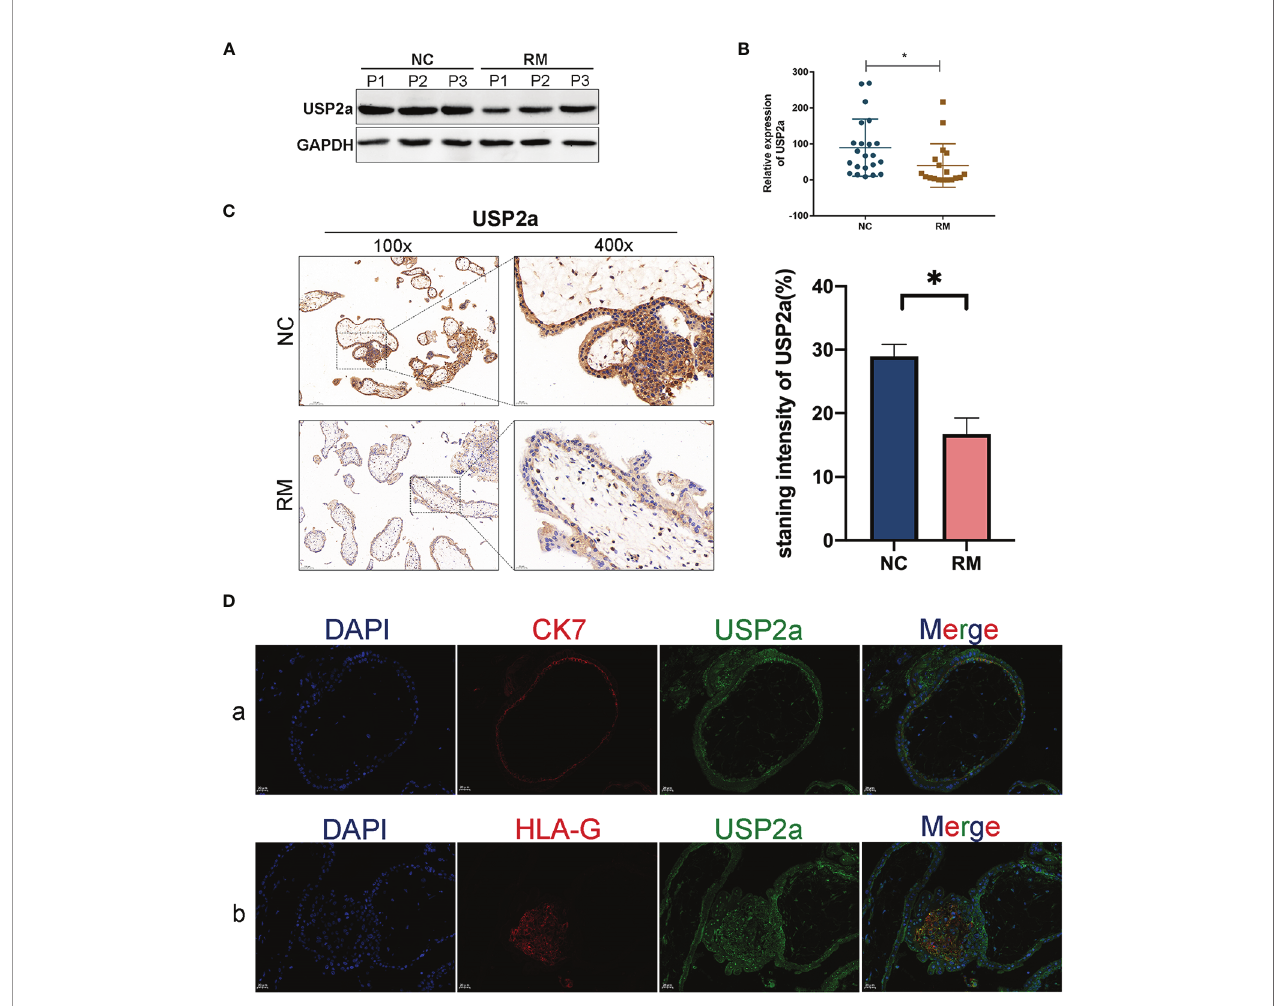
FIGURE 1 | USP2a is down-regulated in placental in patients with recurrent miscarriage (RM). (A, B) Comparison of relative mRNA and protein expression levels of USP2a in placental villous tissues between RM patients (n = 18) and normal women (n = 22) by RT ‐ PCR and western blot. (C) Representative immunohistochemical images of villous expression and localization of USP2a in RM patients (n = 22) and normal women (n = 25). The staining intensity was quanti fi ed using the ImageJ software. Graphs show the means ± SD. Magni fi cation, 100× and 400×. (D) Representative immuno fl uorescence images: (a) double immune-staining of CK7 (red) and USP2a (green). Magni fi cation, 400×; (b) double immune-staining of HLA-G (red) and USP2a (green) Magni fi cation, 400×. * P < 0.05. Scale bar = 100 m m (100×); Scale bar = 20 m m (400×). mRNA, messenger RNA; RT ‐ PCR, quantitative real ‐ time polymerase chain reaction; RM, recurrent miscarriage; USP2a, ubiquitin ‐ speci fi c protease 2a; CK7, cytokeratin 7; HLA-G, human leukocyte antigen